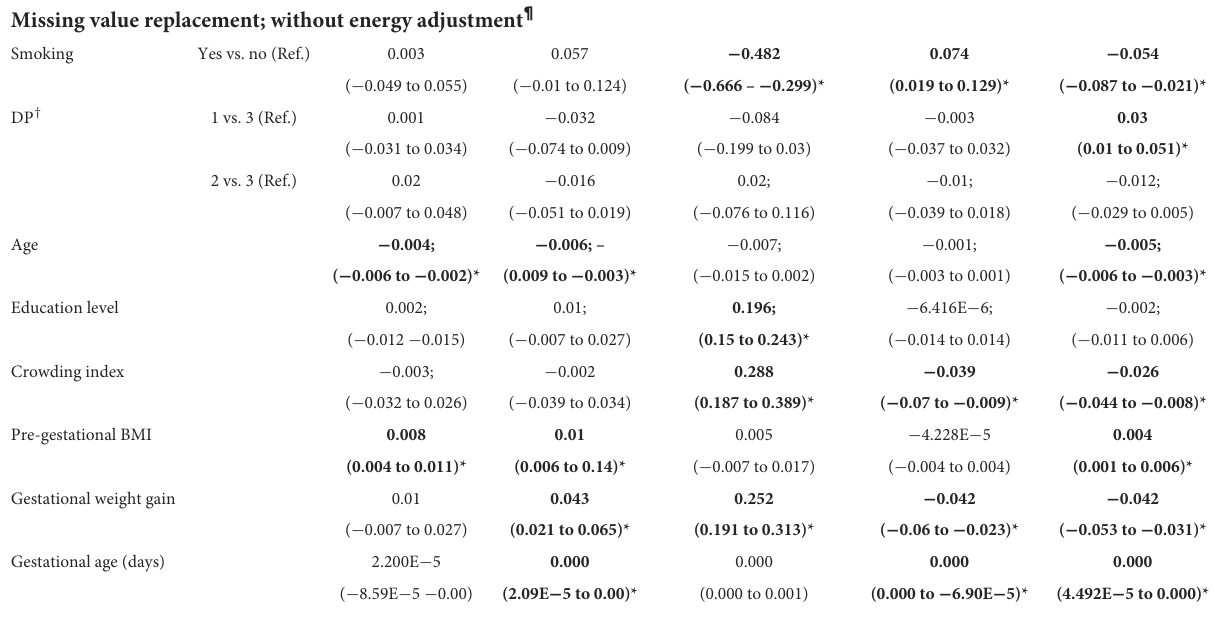
TABLE 12 Multivariate analysis of neonatal